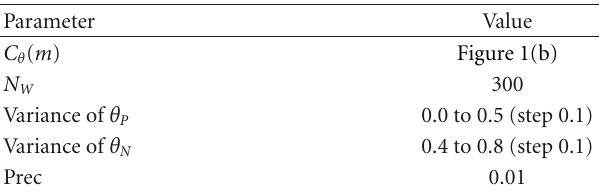
Table 1: Parameter settings for the single layer optimization method in Algorithm 2 used in our